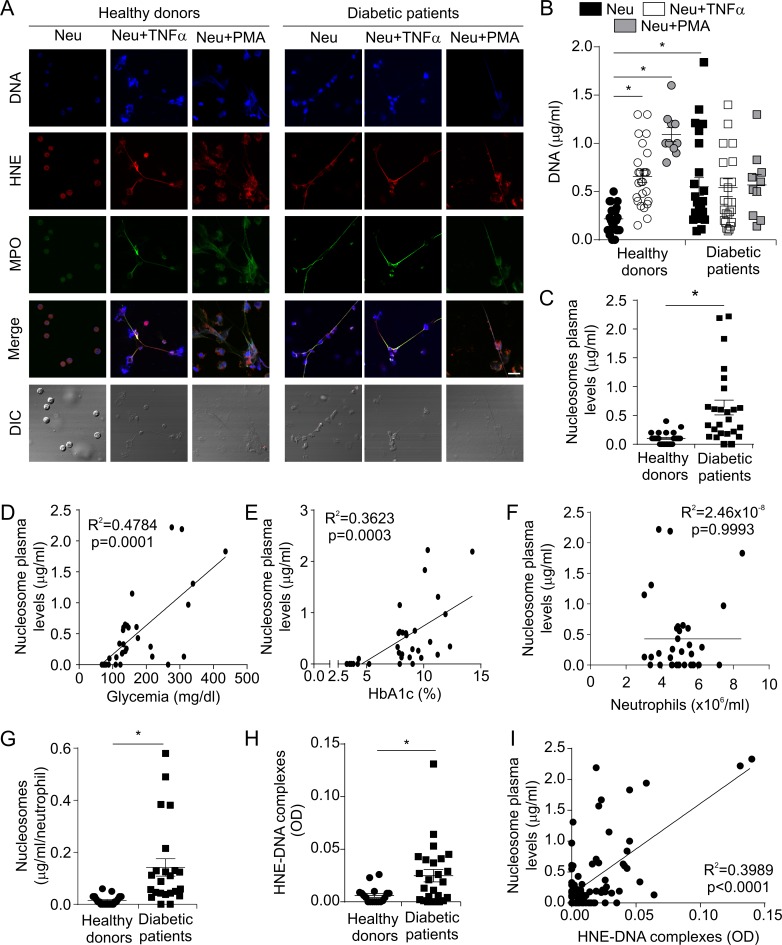
NET formation in diabetic patients.Neutrophils (Neu, 5x105/ml) were isolated from healthy donors or recently diagnosed diabetic patients and stimulated or not with TNFα (20 ng/ml) or PMA (50 nM), and then the cells (A) were fixed, permeabilized and stained with TO-PRO 3 for DNA (blue), the specific markers anti-human neutrophil elastase (HNE, red) and anti-MPO (green) and visualized by confocal fluorescence microscopy (original magnification, 60X, scale bar: 20 μm, the images are representative of ten patients) or (B) treated with MNase and NET-associated DNA was quantified in the supernatants by fluorometry. (C) Nucleosome plasma levels were measured in the plasma of healthy donors or diabetic patients by ELISA. Correlation between nucleosome plasma levels and (D) glycaemia, (E) HbA1c or (F) neutrophil counts of diabetic patients. (G) Normalization of nucleosome levels to individual neutrophil counts. (H) HNE-DNA complex levels (optical density, OD) were measured in plasma of healthy donors or diabetic patients by ELISA. (I) Correlation between nucleosome levels and HNE-DNA complexes. *p<0.05. Student’s t-test was used in Panels (B), (C), (G) and (H) and the Pearson lineal model in Panels (D), (E), (F) and (I).